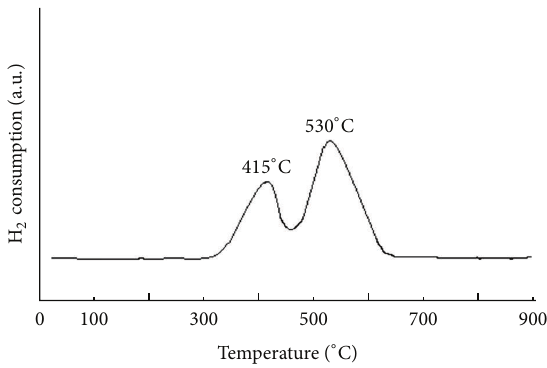
Figure 6: TPR profile of Fe/SiO 2 nanocatalyst.